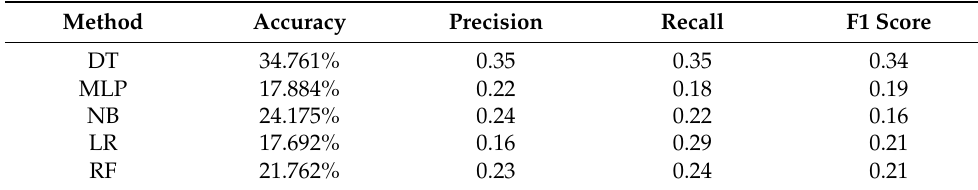
Table 8. Comparison of experimental results using the typical classification methods for seven classes of Arabic comments.